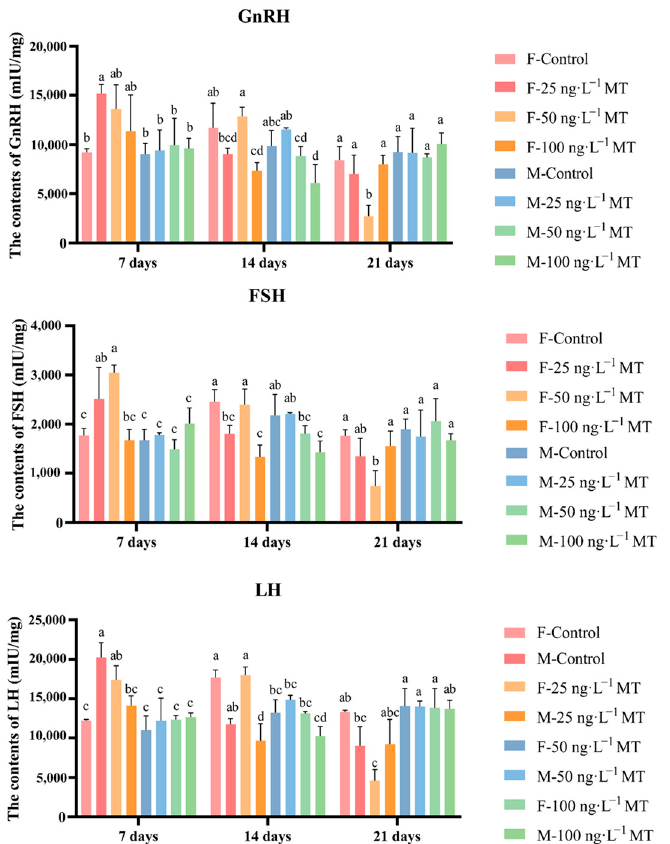
Figure 2. Effects of different doses of 17 α -methyltestosterone on the concentrations of GnRH, FSH, and LH in G. rarus . Data are expressed as mean ± SD. Statistically significant differences are indicated by different letters ( p < 0.05).